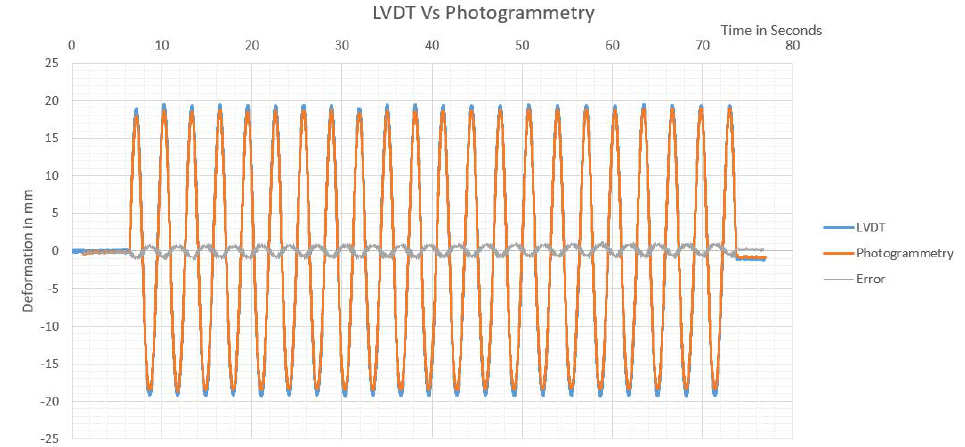
Figure 14. Shaking table monitored oscillations using LVDTs vs. photogrammetry from the second station.